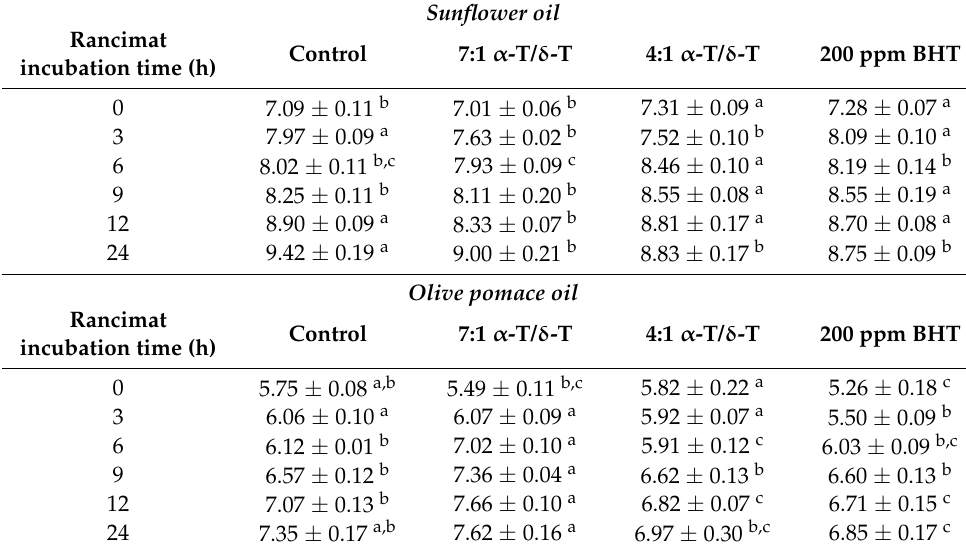
Table 7. p -Anisidine values ( ± SD) of sunflower oil and olive pomace oil samples. Inside rows with a specific superscript letter (e.g., a–c) indicate a significant ( p < 0.05) difference for each Rancimat incubation